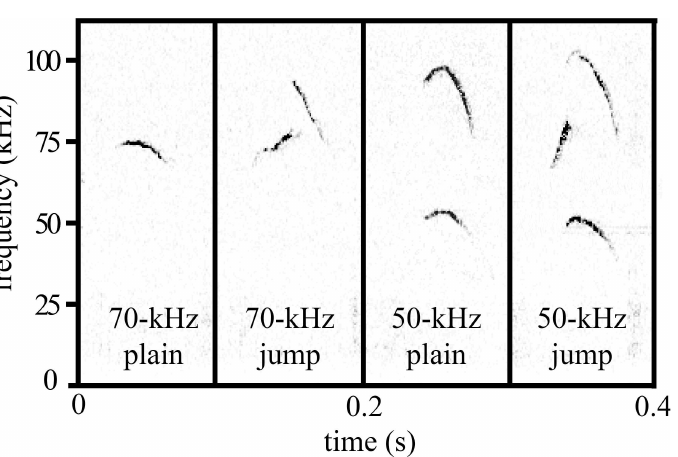
Fig 1. Spectrograms of representative ultrasonic vocalizations (USVs) produced by male mice during same-sexsocial encounters. USVs were classifiedbasedon frequency(50-kHz vs. 70-kHz) and the presenceof frequency jumps, yieldingfour USV types: “70-kHz plain”, “70-kHz jump”, “50-kHz plain”, and “50-kHz jump”. See methods for more detailsregardingultrasonic